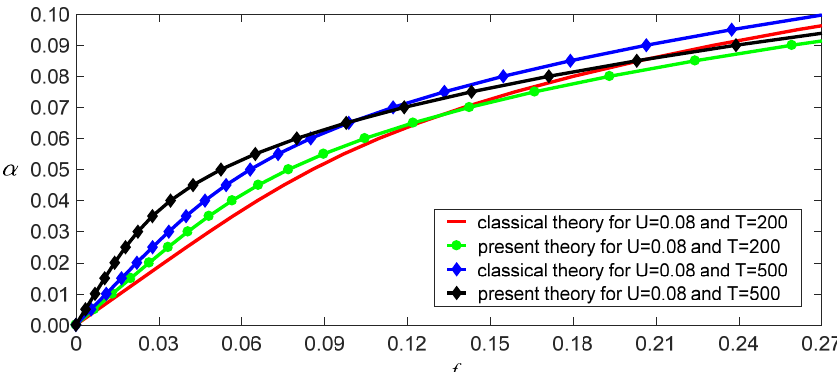
Figure 6. Load–response curves of vibration amplitudes with two temperatures for ( c , σ , U ) = ( 1, 0, 0.08 ) .